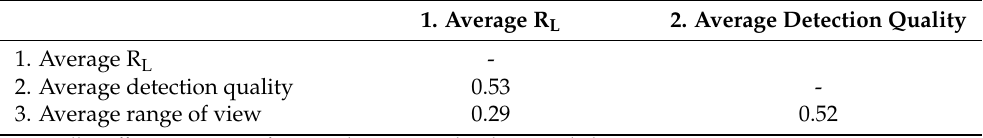
Table 4. Spearman’s coefficients of correlation between examined variables.